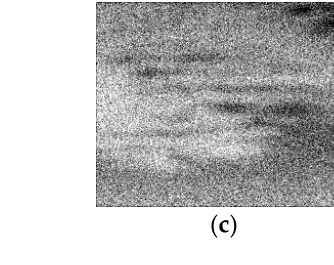
Figure 4. ( a ) Seq8; ( b ) Seq9; ( c ) Seq10.